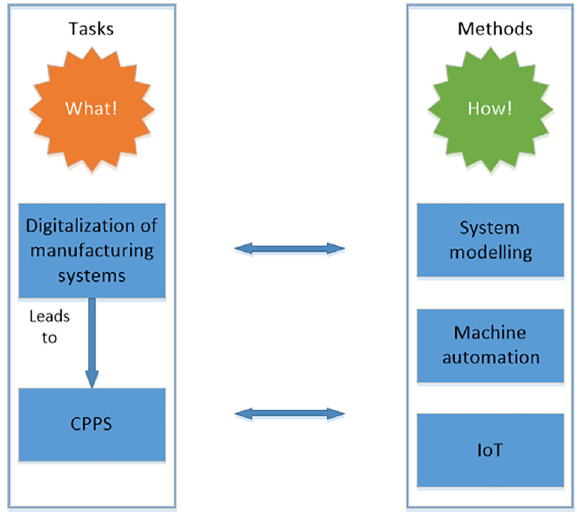
Fig. 1. Structure of the